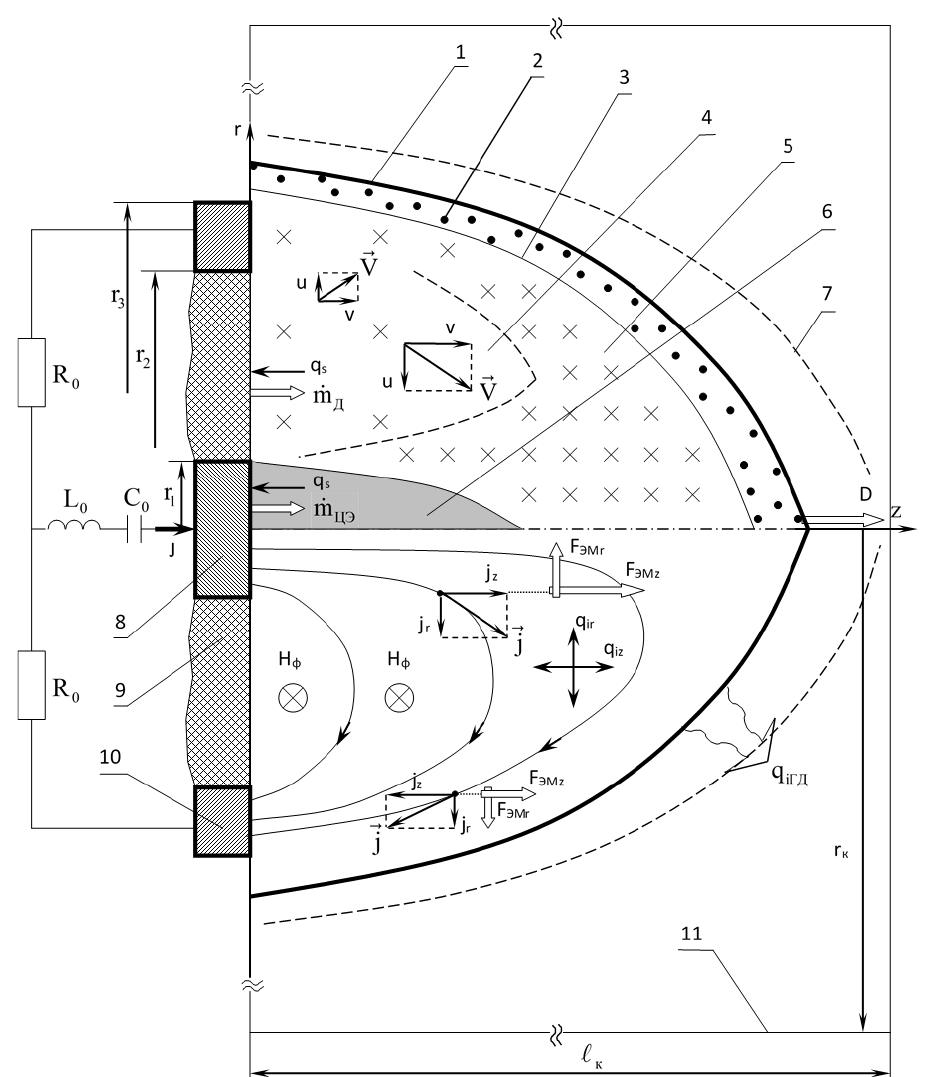
Figure 1. MPC diagram and general structure of a plasma discharge IPC diagram: 1 — shock wave (SW) in gas; 2 — shock-compressed gas; 3 — contact boundary; 4 — region of the accelerated plasma of interelectrode dielectric insert (IDI); 5 — area of shock-compressed plasma of IDI vapors; 6 — plasma of vapors of the central electrode; 7 — border of the area of radiation exposure; 8, 10 — central and outer electrodes; 9 — IDI; 11 — chamber walls (or the boundary of the computational domain D). F EM is the electromagnetic force, q s is the flux density of radiation incident on a condensed barrier, q iГД is the flux density of radiation coming from the surface of the shock wave, l k is the longitudinal dimension of the computational domain, r k is the transverse size of the computational domain, m Д is the mass flow coming from the surface of the interelectrode insert, m ЦЭ is the mass flow coming from the surface of the central electrode, and R 0 is the active resistance in an external electrical circuit. The initial stage of the discharge development—the stage of breakdown of the inter- electrode gap with a duration of ≤ 1 µ s—is characterized by a pronounced inhomogeneity of the distribution of plasma parameters in the interelectrode gap in azimuth. This stage ends with the formation of a narrow (~1 mm) layer of weakly ionized, vapor–gas plasma adjacent to the surface of the end face of the W ~ W 0 electrode system, short-circuiting the interelectrode gap. The energy spent at the breakdown stage and the initial stage of the discharge, from the energetic point of view, does not have a significant effect on the further plasma dynamics of the MPC